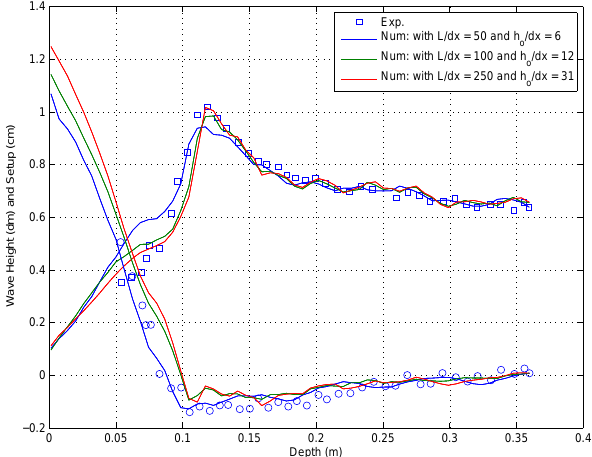
Fig. A4. Computed and measured wave heights and setup for the Hansen and Svendsen case 061071 ( kh o = 0 . 791, H/h o = 0 . 19).